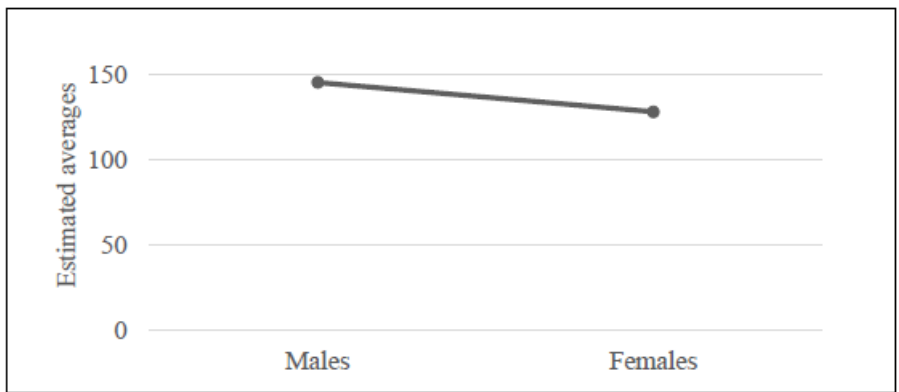
Figure 3. Average use of vamos according to the gender of the informants in the sample.